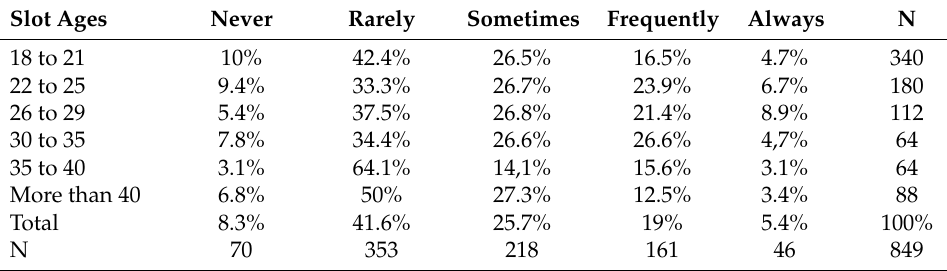
Table 4. Participants’ perception of media outlets as distributors of fake news (per row).